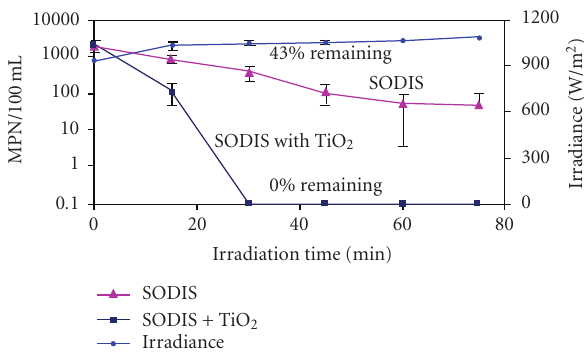
Figure 9: Decrease in faecal coliforms in natural spring water exposed to direct sunlight, comparing SODIS to TiO 2 -enhanced SODIS (with permission from